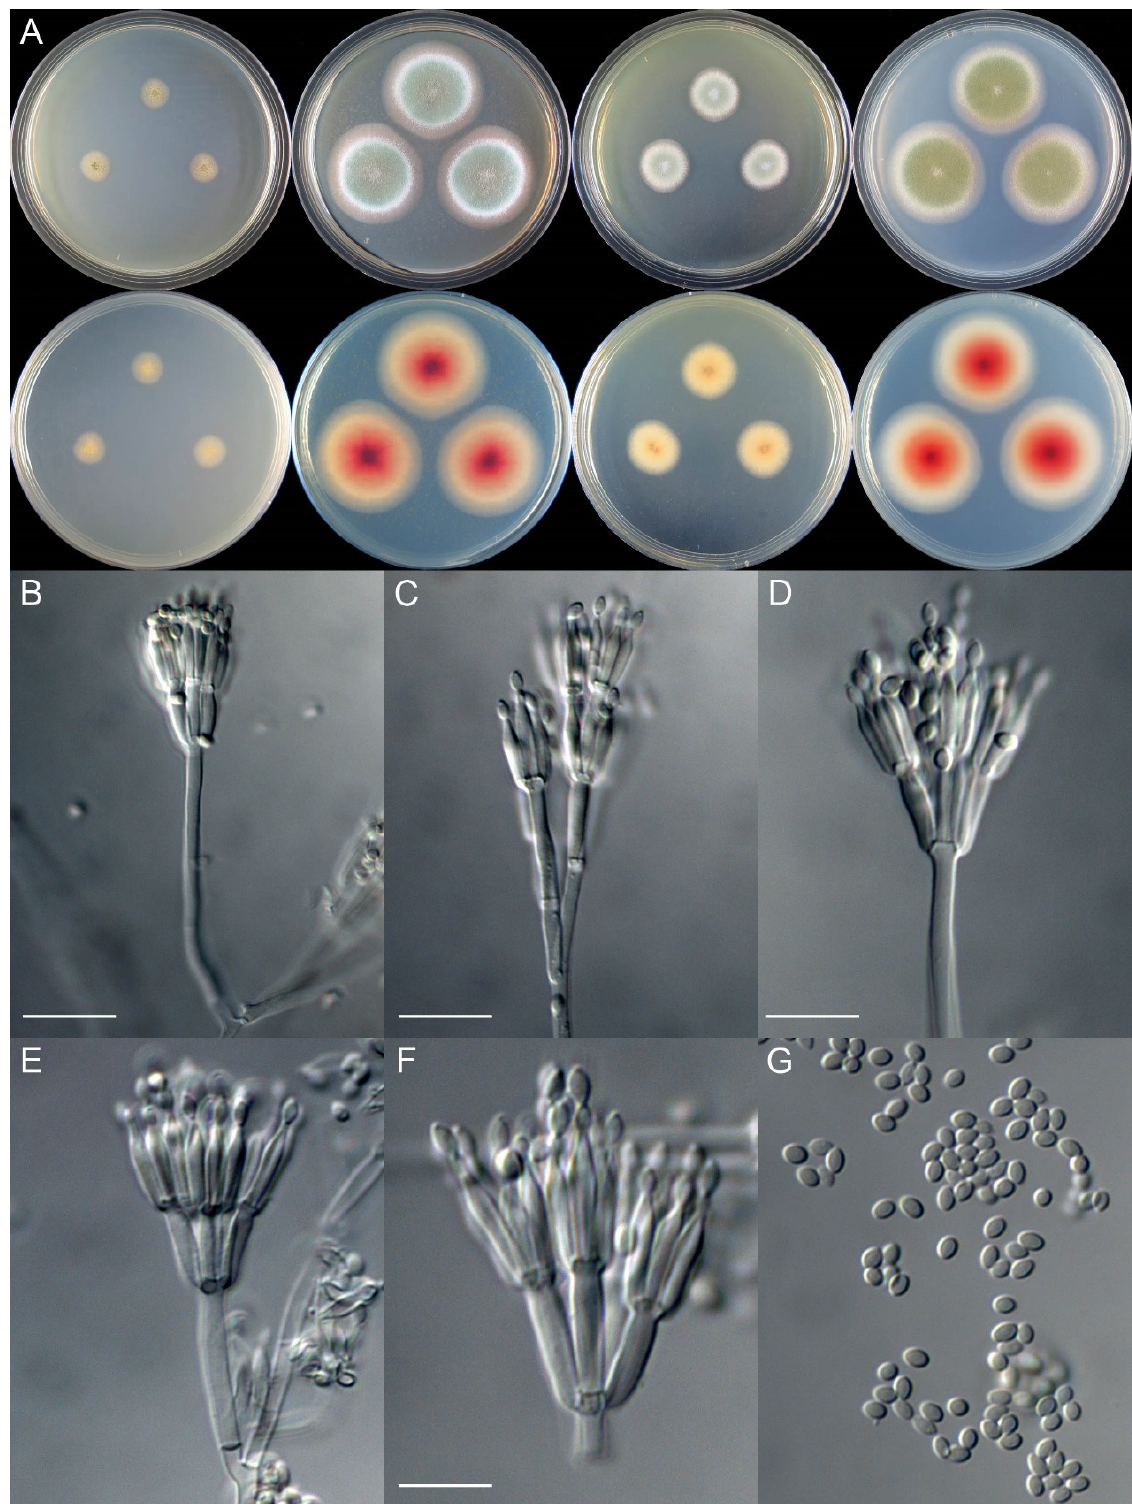
Figure 3. Colonial and microscopic morphology of Talaromyces shilinensis (XCW_SN259). ( A ) Colony phenotypes (25 °C, 7 days; top row left to right, obverse CYA, MEA, YES, and PDA; bottom row left to right, reverse CYA, MEA, YES, and PDA); ( B – F ) Conidiophores; ( G ) Conidia. Bars: B = 15 μ m; C = 12.5 μ m; D = 10 μ m, applies to E and G; F = 7.5 μ m.